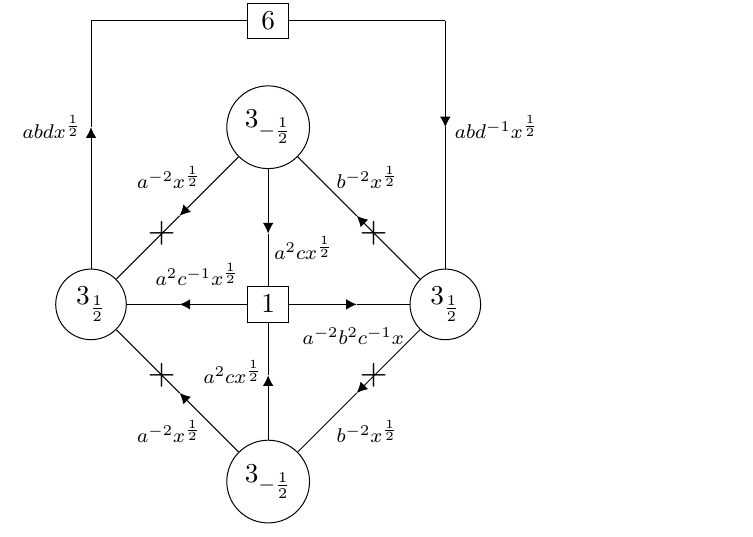
Figure 15 . The quiver for the theory resulting from the compactification of the 5 d SU(2) × SU(8) SCFT on a torus with flux (1 , − 1; 1 , − 1 , 0 , 0 , 0 , 0 , 0 , 0)